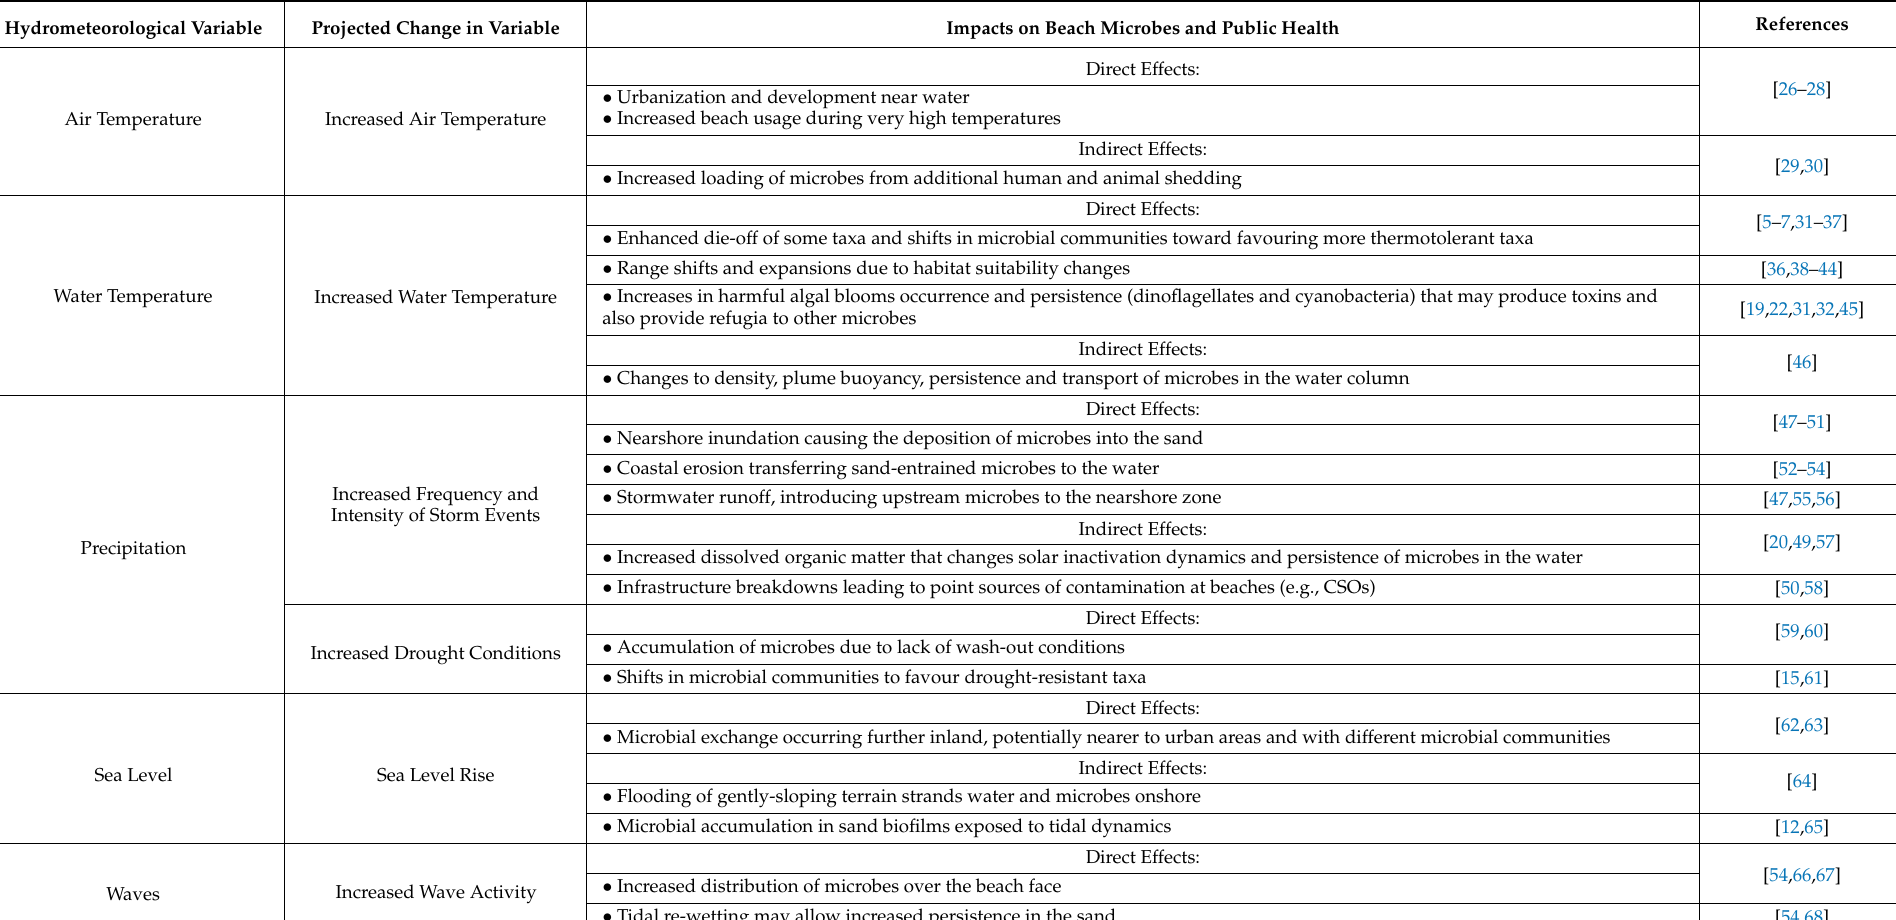
Table 2. Examples of how predicted variability of environmental/climatic factors may affect pathogenic microbial exposure burdens and human health risks at the nearshore